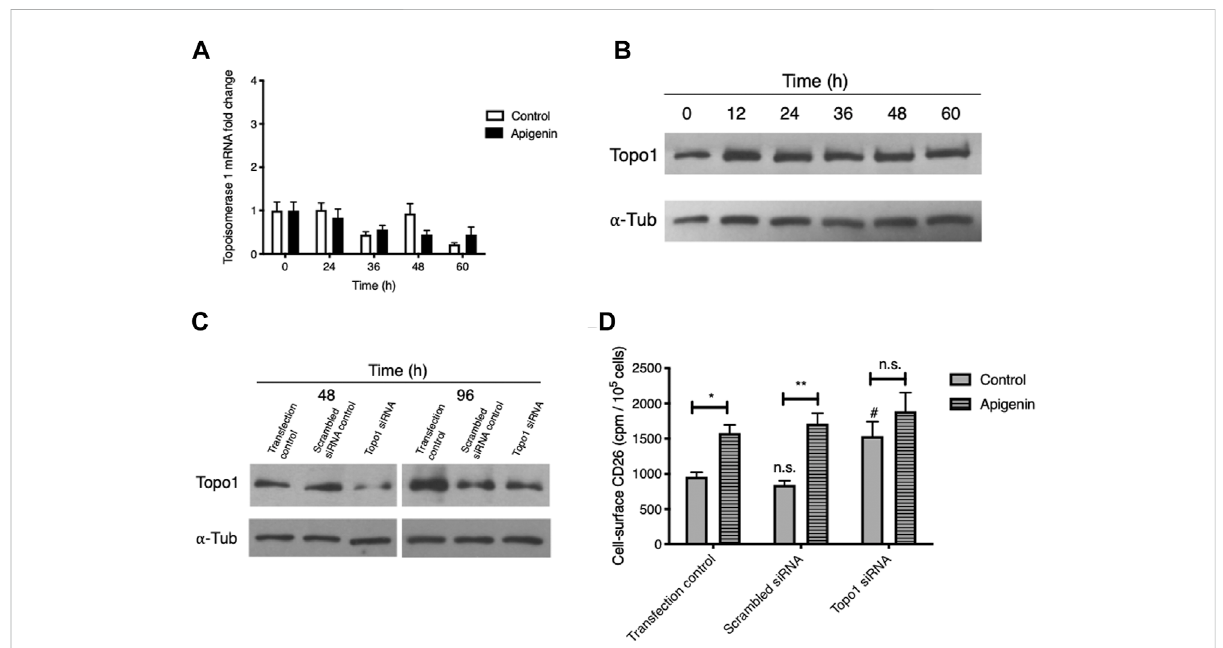
FIGURE 3 Apigenin ’ s ability to upregulate CD26 requires Topo1 but does not come from changes in Topo1 expression. (A) Apigenin does not alter Topo1 mRNA expression. HT-29 cells weretreatedwith apigenin(30 µM)orvehiclecontrol for thetimes indicated and Topo1 mRNAlevelswerequanti fi ed byq-RT-PCR. Values aremeans± SEM ( n = 3). (B) Apigenin does not alter Topo1 proteinexpression. HT-29 cells weretreated with apigenin(60 µM) for the times indicated and Topo1 protein levels were quanti fi ed by western blotting relative to a-tubulin as loading control. (C) siRNA knock- down of Topo1. Topo1 protein levels were measured after 48 h or 96 h by western blot. (D) Knock-down of Topo1 enhances cell-surface CD26 and abrogates the apigenin upregulation of CD26. CD26 levels were evaluated 48 h following apigenin (60 µM) treatment. Values are means ± SEM ( n = 4), from 3 independent experiments. #, p < 0.05, enhancement by knock-down; *, p < 0.05 and **, p < 0.01, enhancement by apigenin. n.s., not signi fi